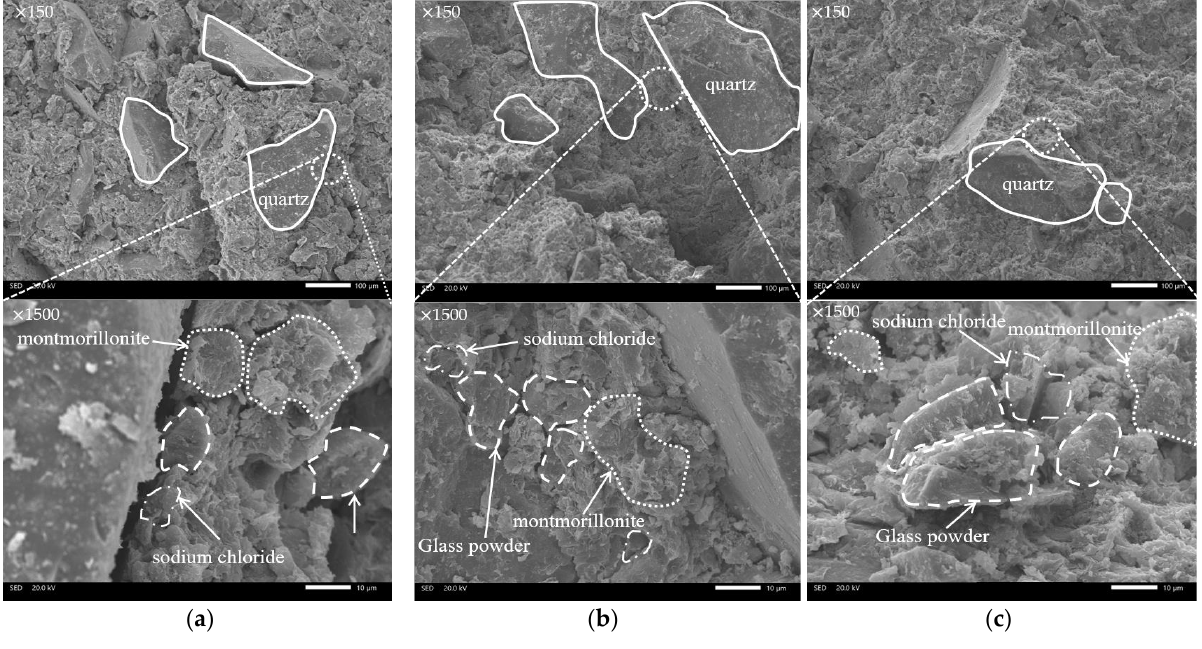
Figure 10. ( a ) 0.5% STGP content similar material microstructure; ( b ) 1% STGP content similar material microstructure; ( c ) 5% STGP content similar material microstructure.